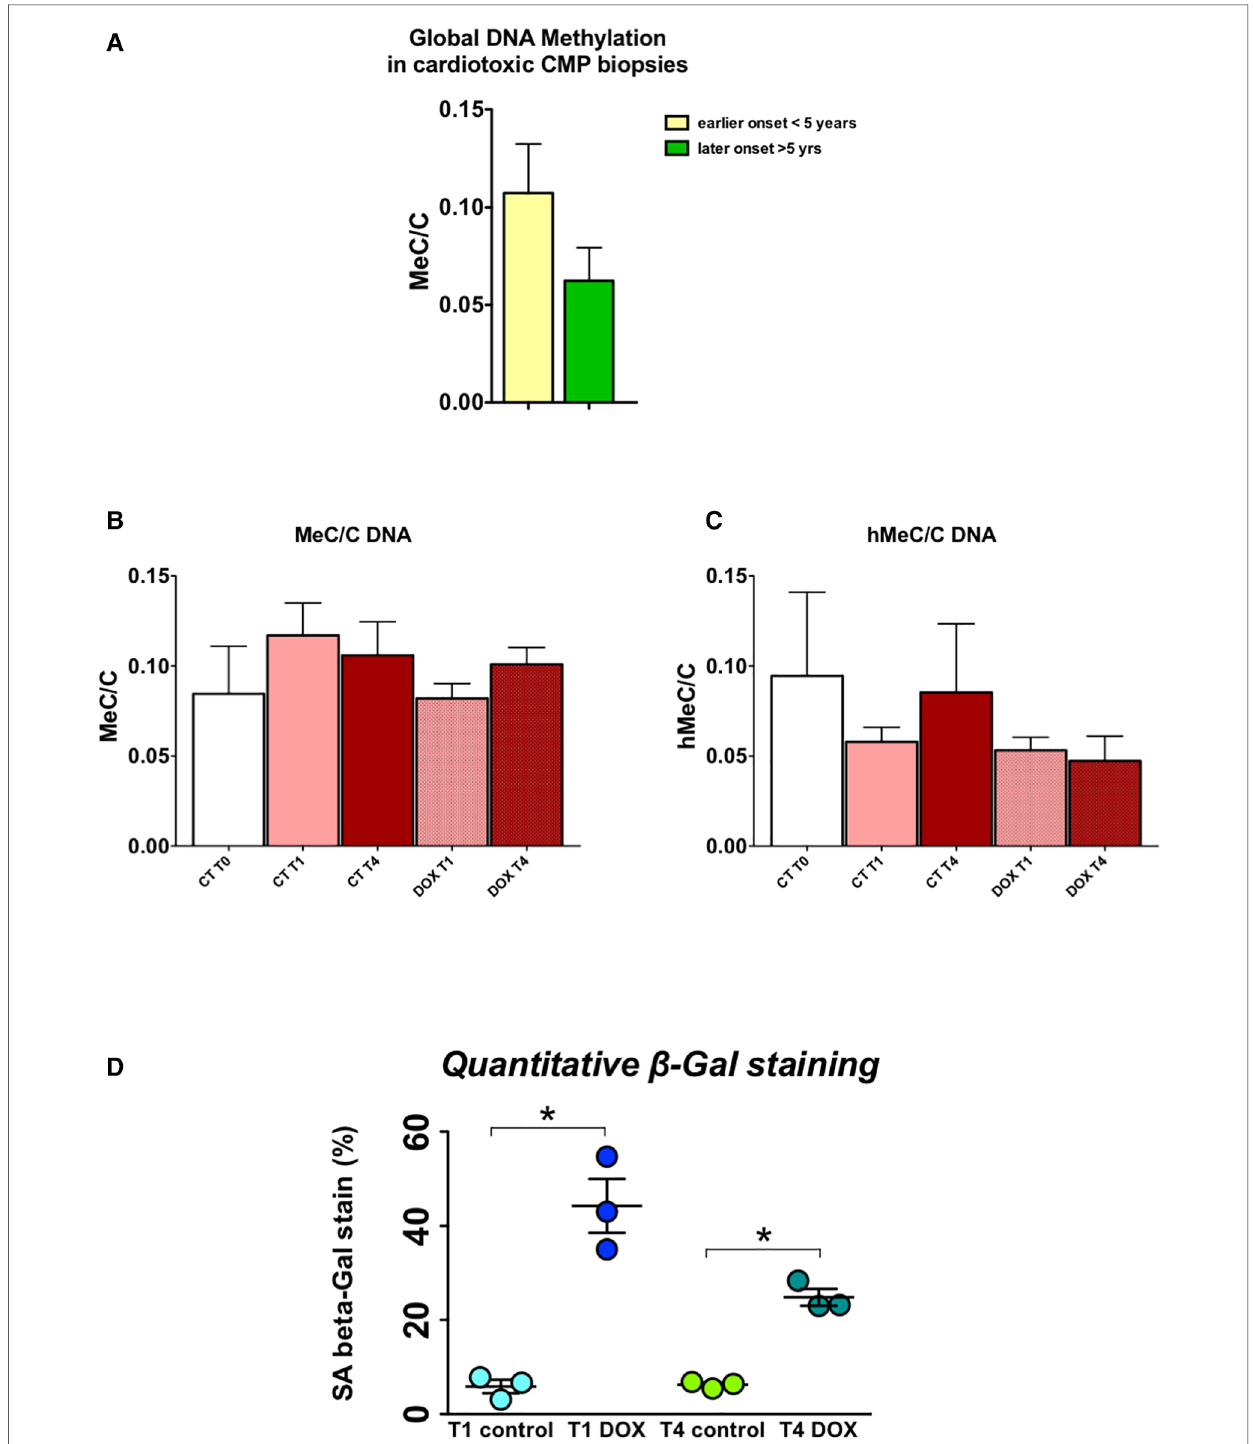
FIGURE 6 DNA methylation/demethylation patterns in biopsies of patients with chemotherapy-induced heart failure mimic patterns observed in H9c2 cells, which show increased senescence even long after a short-term doxorubicin administration. ( A ) Relative global levels of methylated cytosine vs. demethylated cytosine levels (MeC/C) in early vs. late cardiotoxicity biopsies shows increased methylation at a later time point after administration of chemotherapy, measured by liquid chromatography mass spectrometry; ( B ) Relative MeC/C levels trend to decrease over time after doxorubicin administration in H9c2 cells, while ( C ) hMeC/C levels are also lower; * p <0.05 in two-way ANOVA. ( D ) Quantitative beta galactosidase staining – a marker of cell senescence – shows strongly increased senescence in doxorubicin cells, one and three weeks after treatment, indicative of a memory